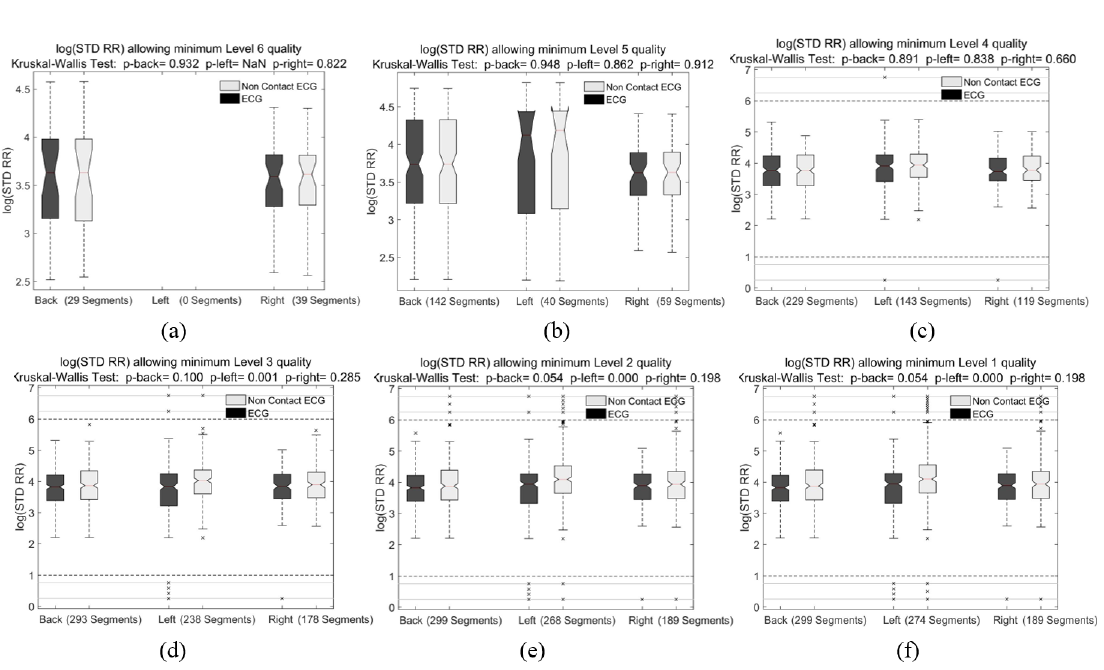
SQI-Fusion 0.82